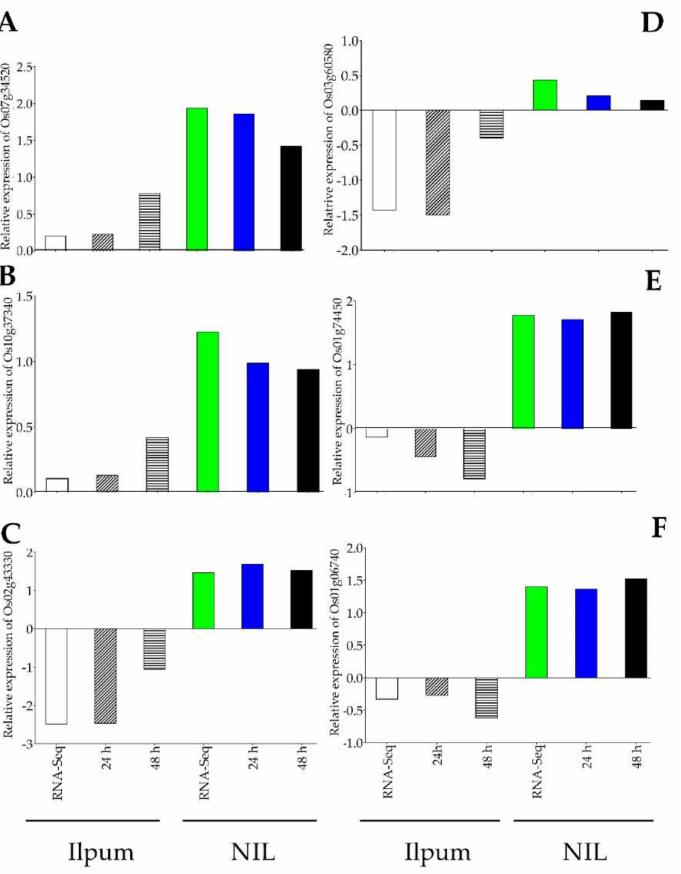
Figure 8. qPCR validation of differentially expressed genes between Ilpum and NIL. ( A ) Enhanced transcript accumulation of Os07g34520 and ( B ) Os10g37340 in NIL compared to Ilpum in response to GRH feeding. ( C ) Differential expression of Os02g43330, ( D ) Os03g60580, ( E ), Os01g74450, and ( F ) Os01g06740 between Ilpum and NIL under the same